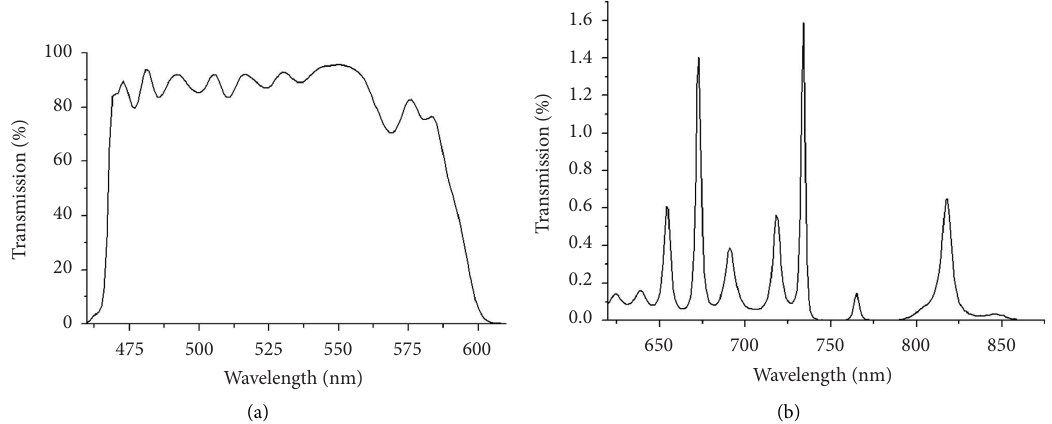
Figure 5: A zoom in at the measured transmission of the bandpass flter. (a) Te average transmission inside the passband is 88%. (b) Maximum transmission outside the passband is a mere 1.6%